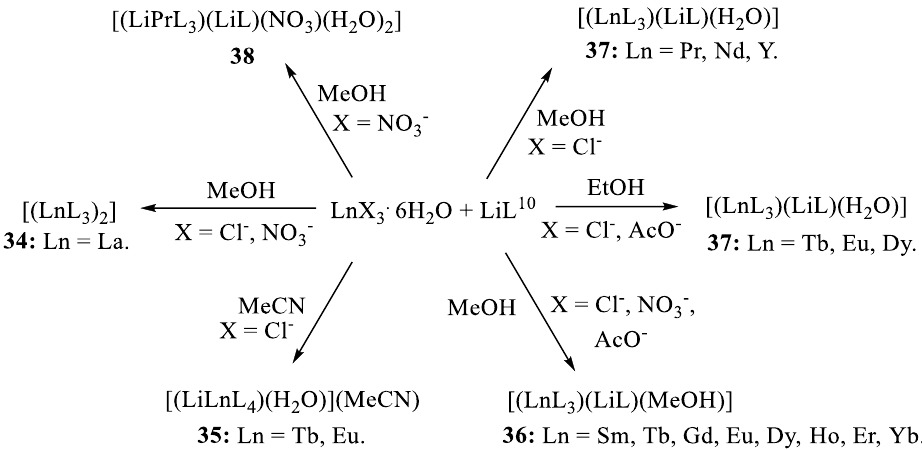
Scheme 13. Synthesis of lanthanide(III) complexes based on lithium β -diketonate ( LiL 10 ).